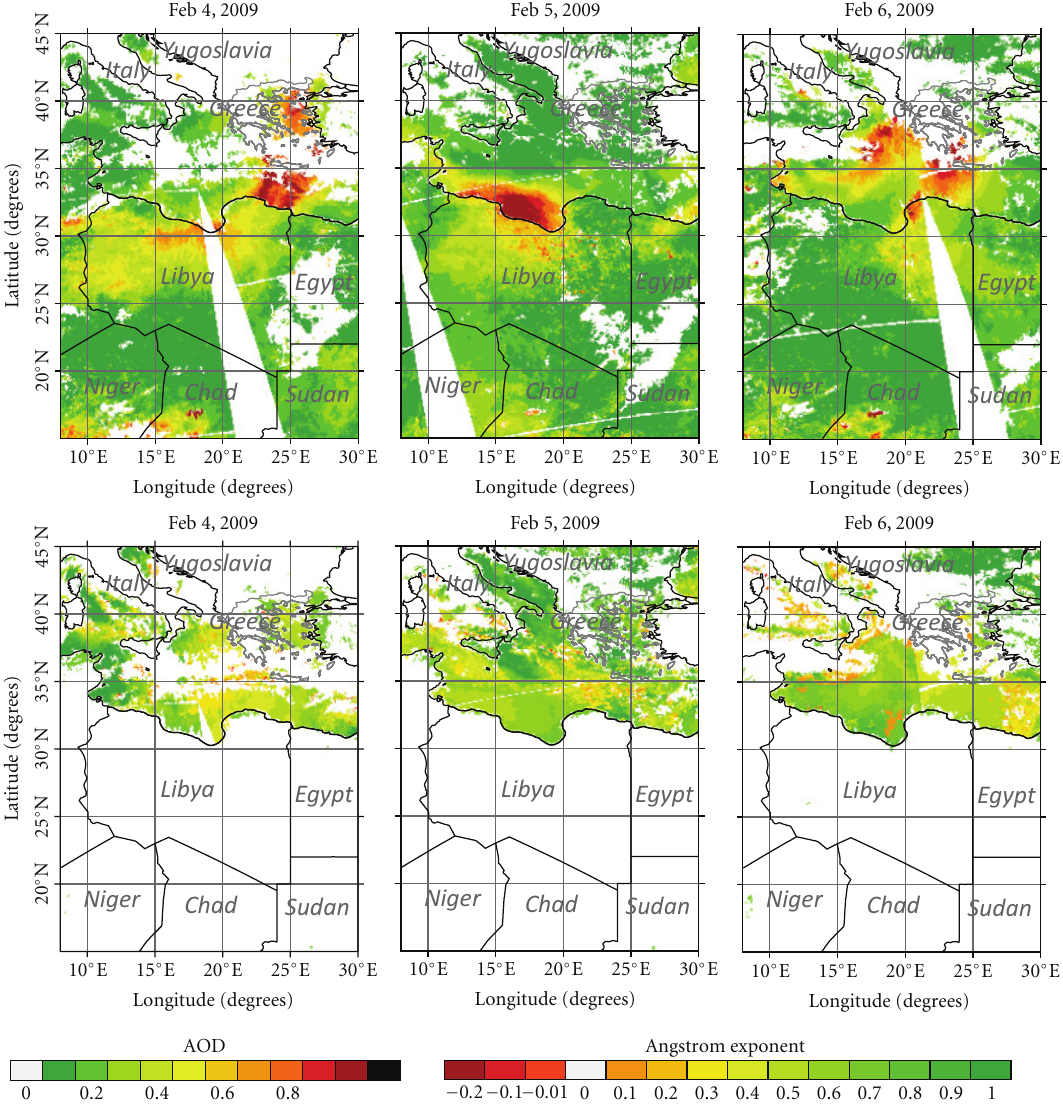
Figure 2: Spatial distribution of MODIS-derived Dark Target AOD (over ocean) and Deep Blue AOD (over land) (upper row) and Angstrom exponent over ocean (lower row) according to Level 2 C005.1 Aqua-MODIS retrievals for 4 (left column), 5 (mid-column) and 6 (right column) February 2009 over eastern